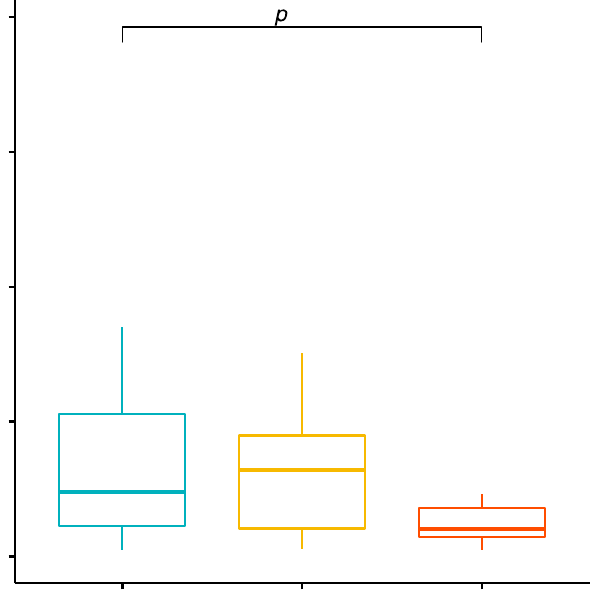
Figure 8. Percentage of CD19+/TLR-4+ B lymphocytes (among CD19+ cells; %) in patients with GD before treatment, after euthyroidism and in the control group.